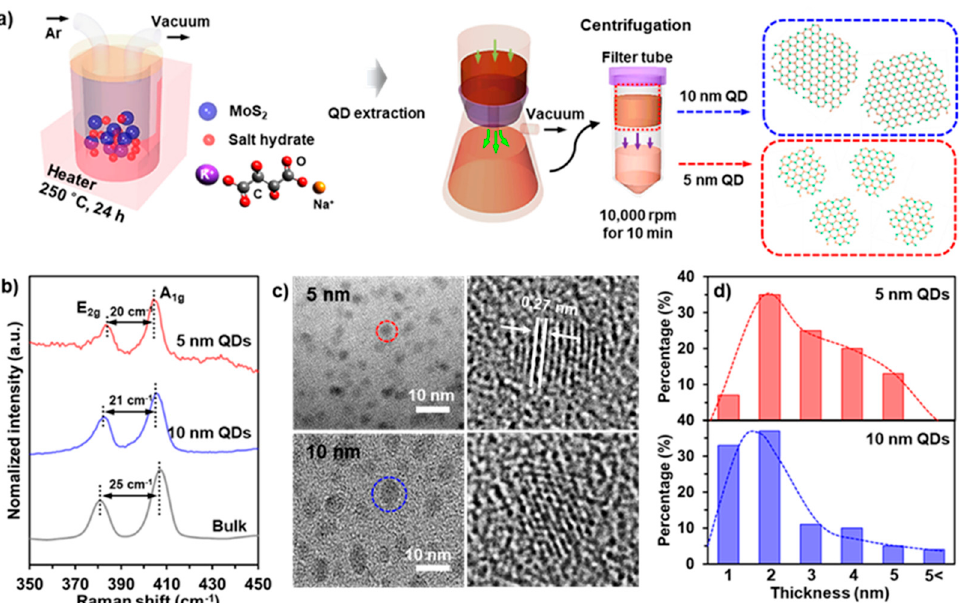
Figure 1. Schematic illustration and characterizations for the MoS 2 quantum dots. ( a ) fabrication step of the 5- and 10-nanometer MoS 2 QDs. ( b ) Raman spectra of the bulk MoS 2 flake, 5- and 10-nanometer MoS 2 QDs. ( c ) TEM (Left) and HR-TEM (Right) images of the MoS 2 QDs. ( d ) Thickness distribution of the MoS 2 QDs.